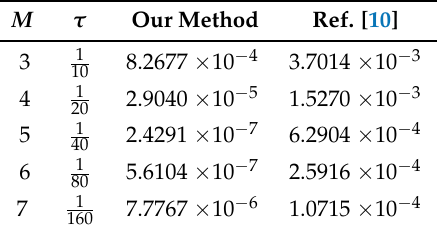
Table 5. Comparison of the maximum absolute errors (MAEs) with [10] of Problem 3 for α = 1.75 and for different values of M .